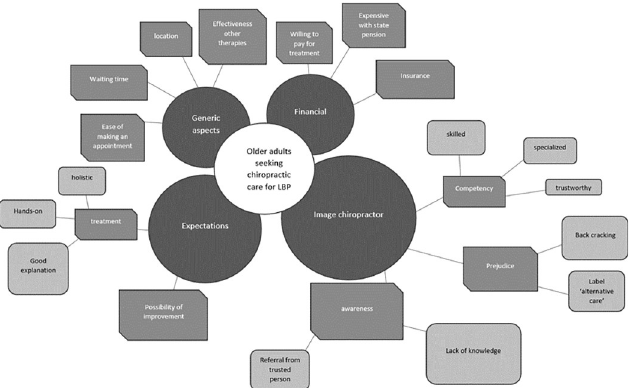
Fig 2. The four identified themes of older adults seeking chiropractic care for their LBP. The dark circles represent the themes, the hexagons represent the subthemes and the rounded rectangles represent the code families.